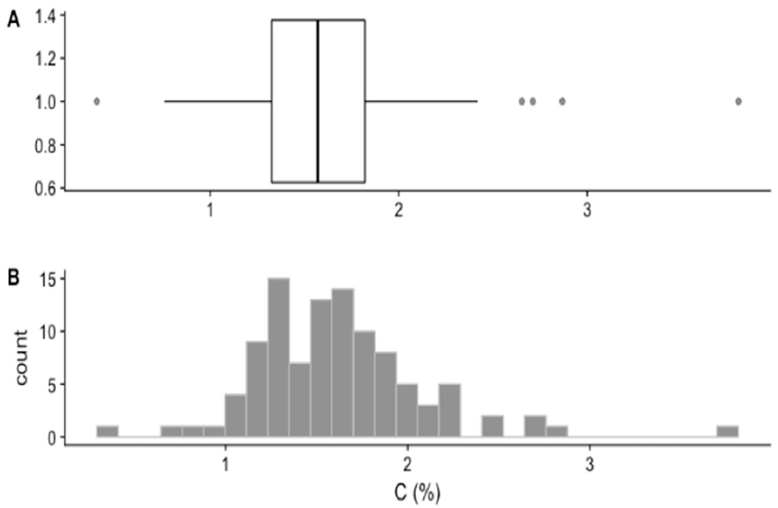
Figure 3. ( A ) Box ‐ and ‐ whiskers plot with outliers and ( B ) Histogram. Figure 3. ( A ) Box-and-whiskers plot with outliers and ( B )